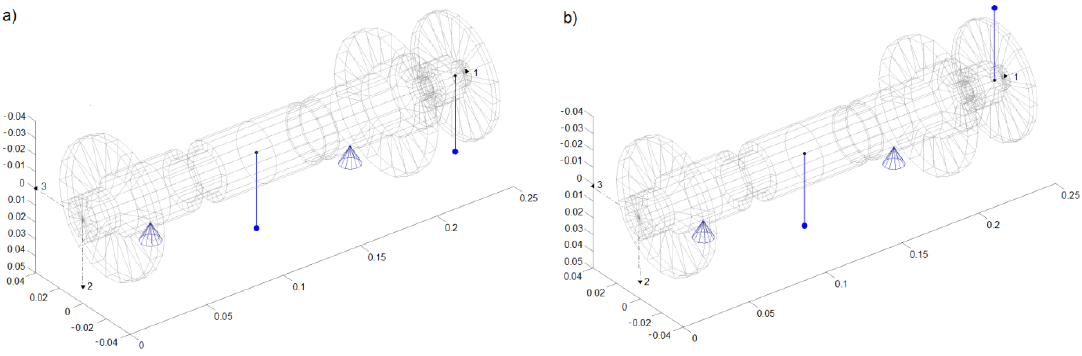
Figure 12: Model of the micro-turbine rotor with two unbalanced discs, No. 2 and No. 4 (a – without angular offset, b – with angular offset).